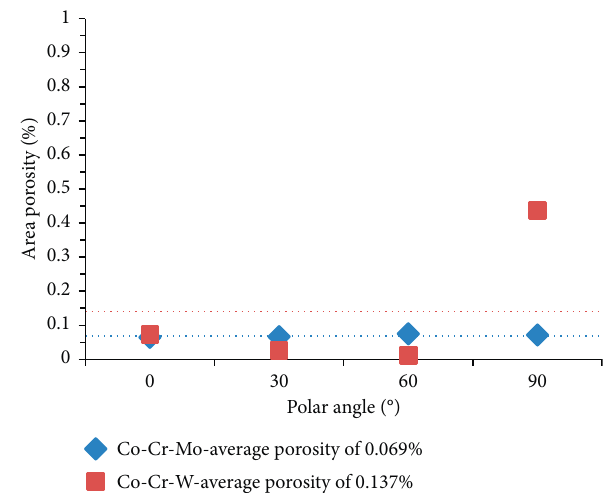
Figure 3: Area porosity of Co-Cr-Mo and Co-Cr-W